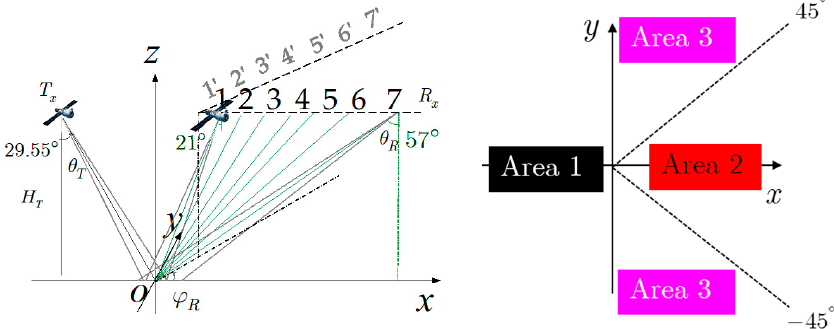
Figure 10. The location diagram of platforms.